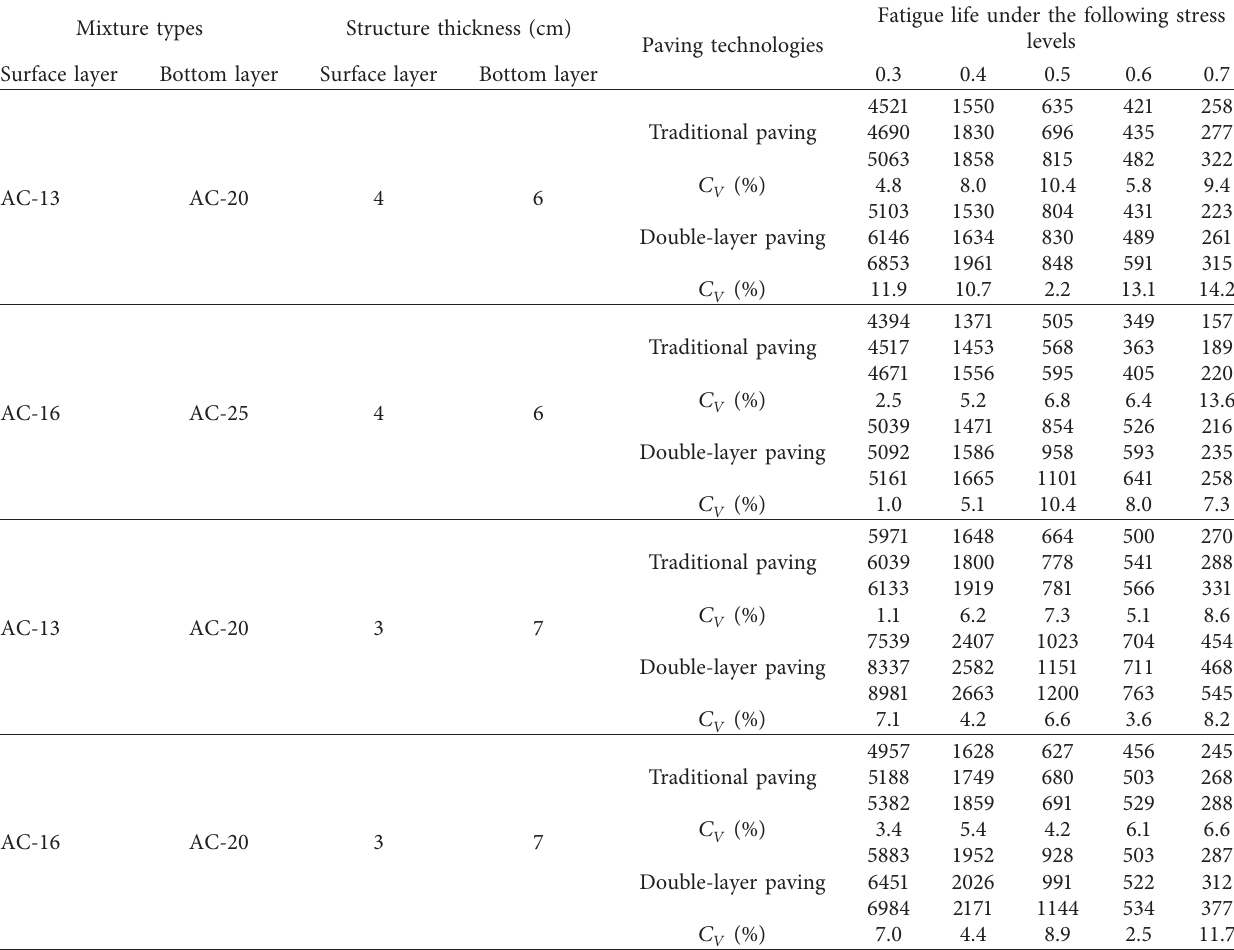
Table 5: Bending fatigue test